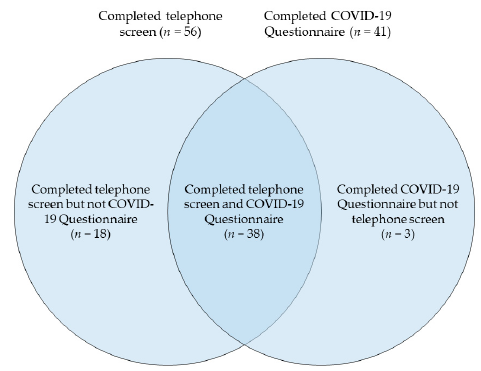
Figure 1. Number of participants who completed telephone screen and COVID ‐ 19 Questionnaire.